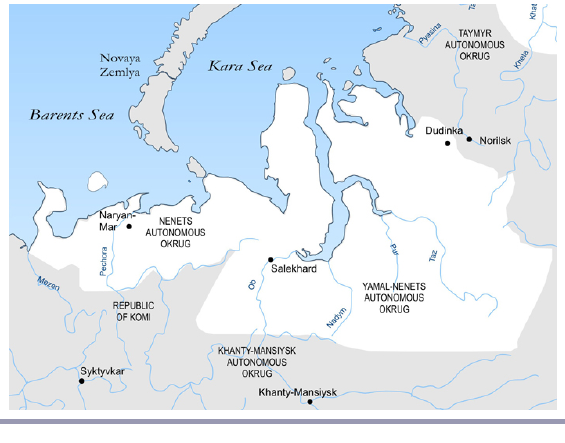
Fig. 2 . Reindeer herding territories (shown in white) of the East European Arctic and West Siberia.